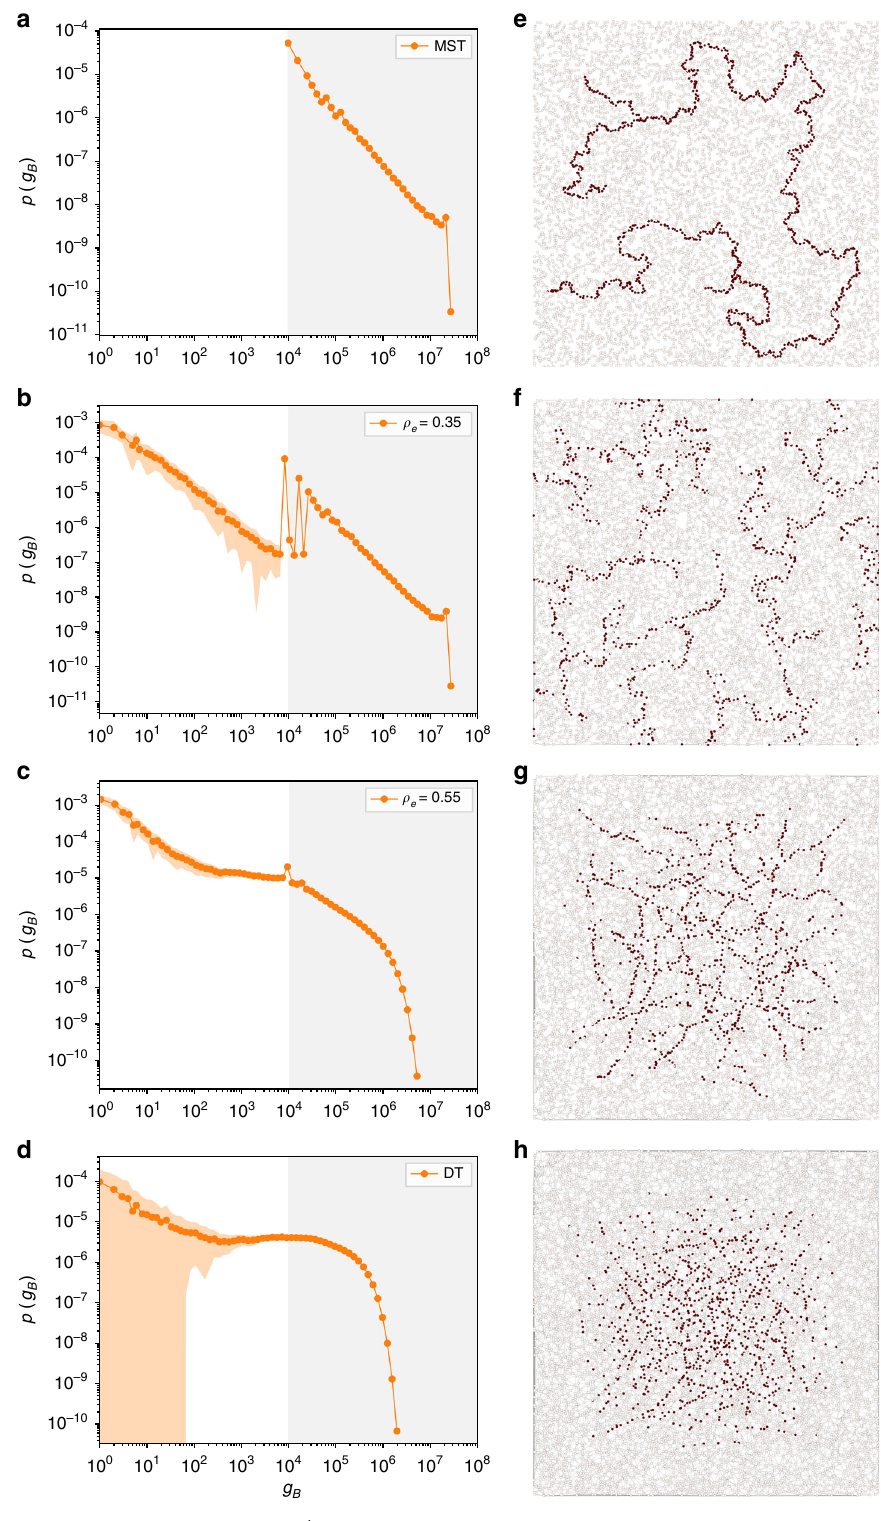
Fig. 3 Effect of edge-density ρ e on the betweenness. N ∼ 10 4 nodes were randomly distributed on the 2D plane and their DT was generated. Edges were removed until the desired edge-density ρ e was reached. a – d The average over a hundred realizations of the resulting BC distribution ranging from the MST to the DT with increasing ρ e . The orange shaded area corresponds to fl uctuations around the average of the realizations, while the silver and white shades separate the “ tree-like ” region from the “ loop-region ” respectively. e – h a single instance of the actual generated network corresponding to each ρ e . Shown in red are the nodes in the 90th percentile and above in terms of their BC